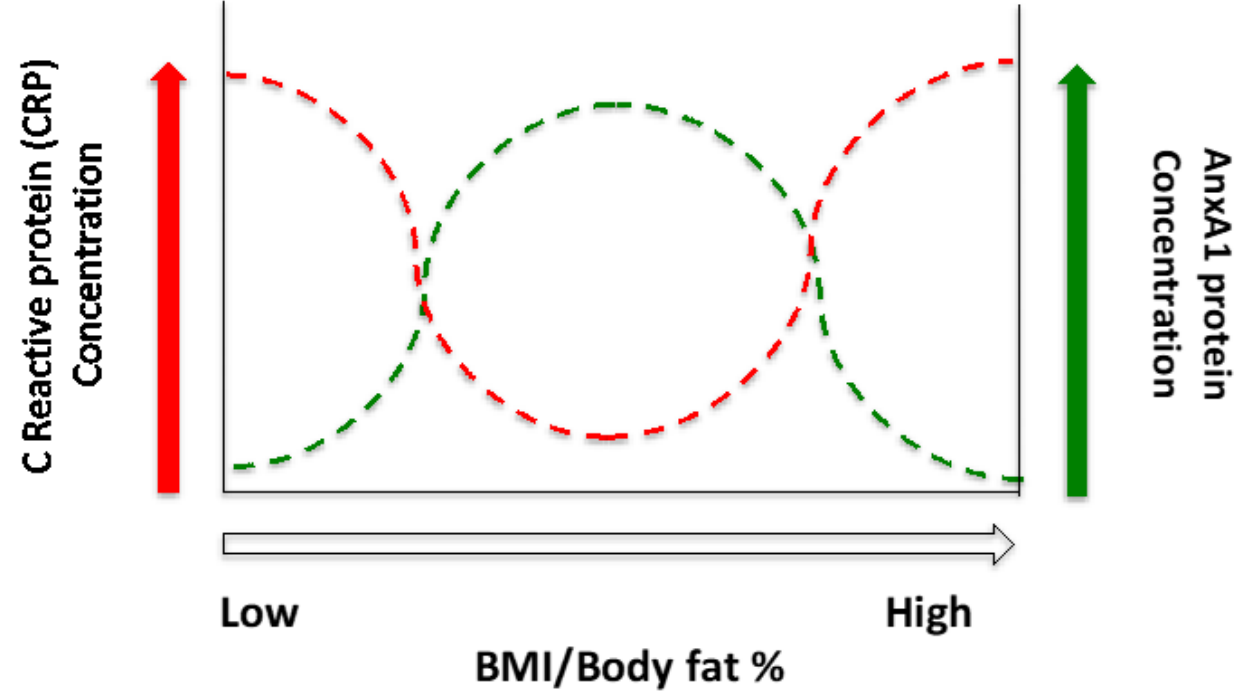
Figure 5. Proposed relationship between CRP and ANXA1 plasma concentrations and BMI/body fat (%) based on the current and previous research.